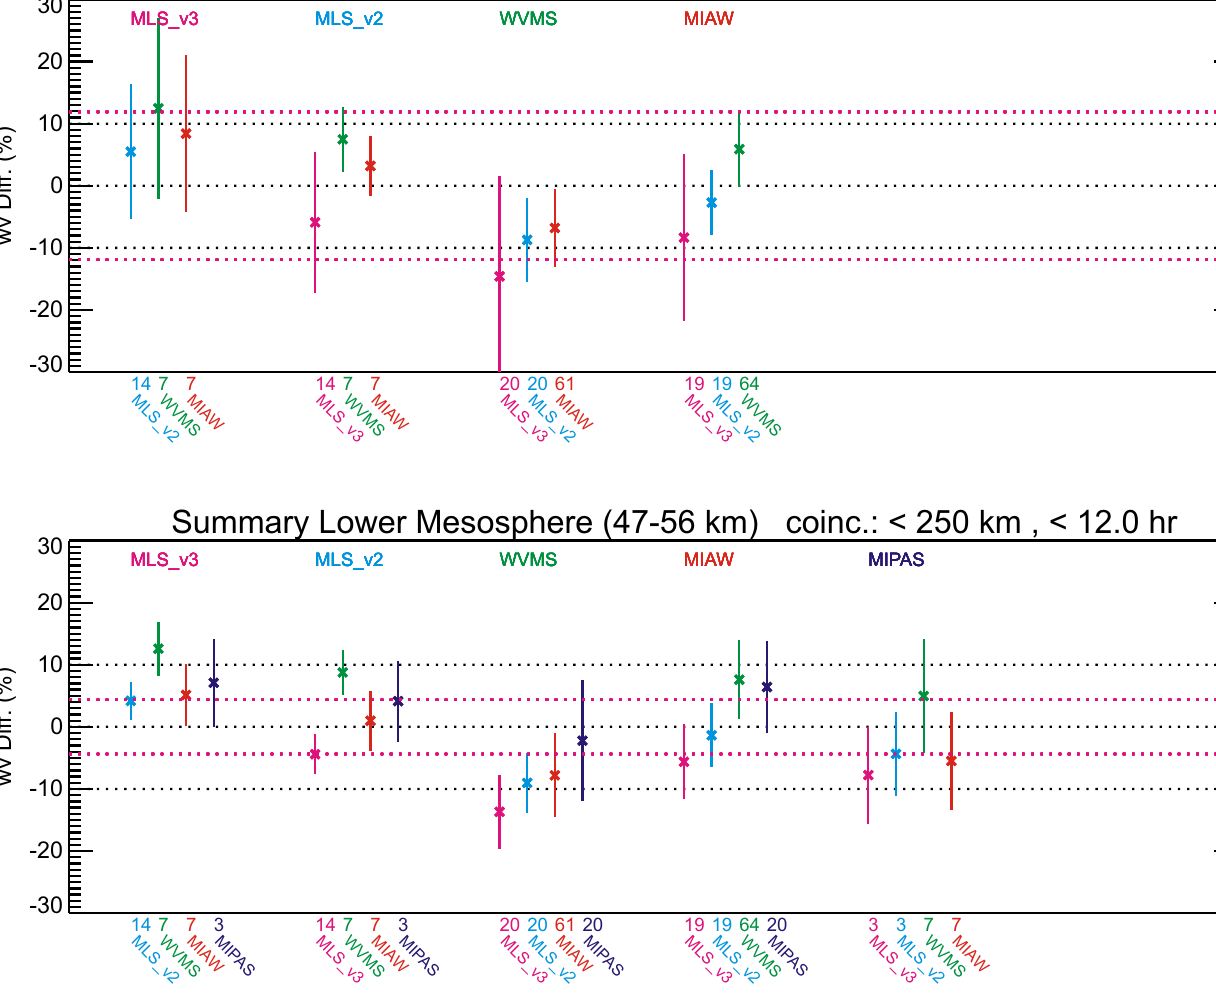
Fig. 20. CFH and MLS v3 were taken as the reference in the troposphere and stratosphere respectively. The top and bottom panels are purposely shifted horizontally to graphi- cally mitigate the 3 %–7 % bias between MLS and CFH. The grey dotted curves again indicate water vapor variability es- timated from the measured standard